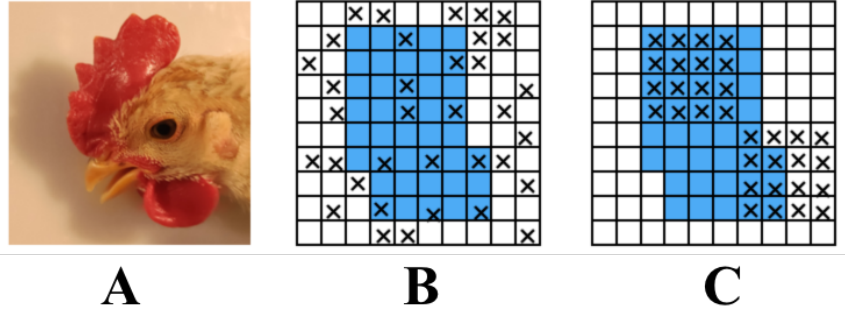
Figure 3. The effect of DropBlock regularization. ( A ) is the original image and the blue parts in ( B , C ) represent the activation units containing semantic information, which cannot be removed. The black cross parts are marginal features of chicken